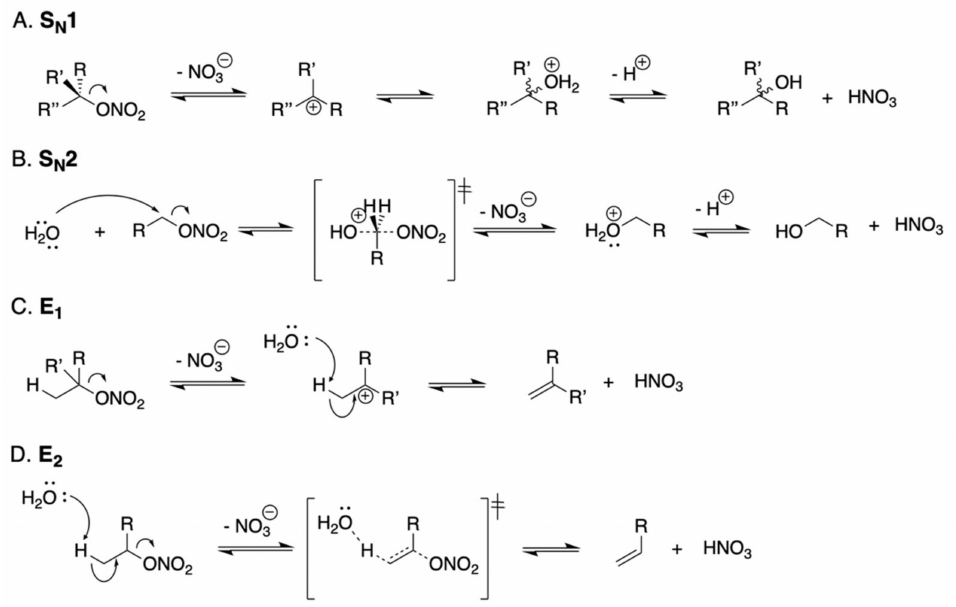
Figure 2. ( A ) S N 1 mechanism; ( B ) S N 2 mechanism; ( C ) E 1 mechanism; ( D ) E 2